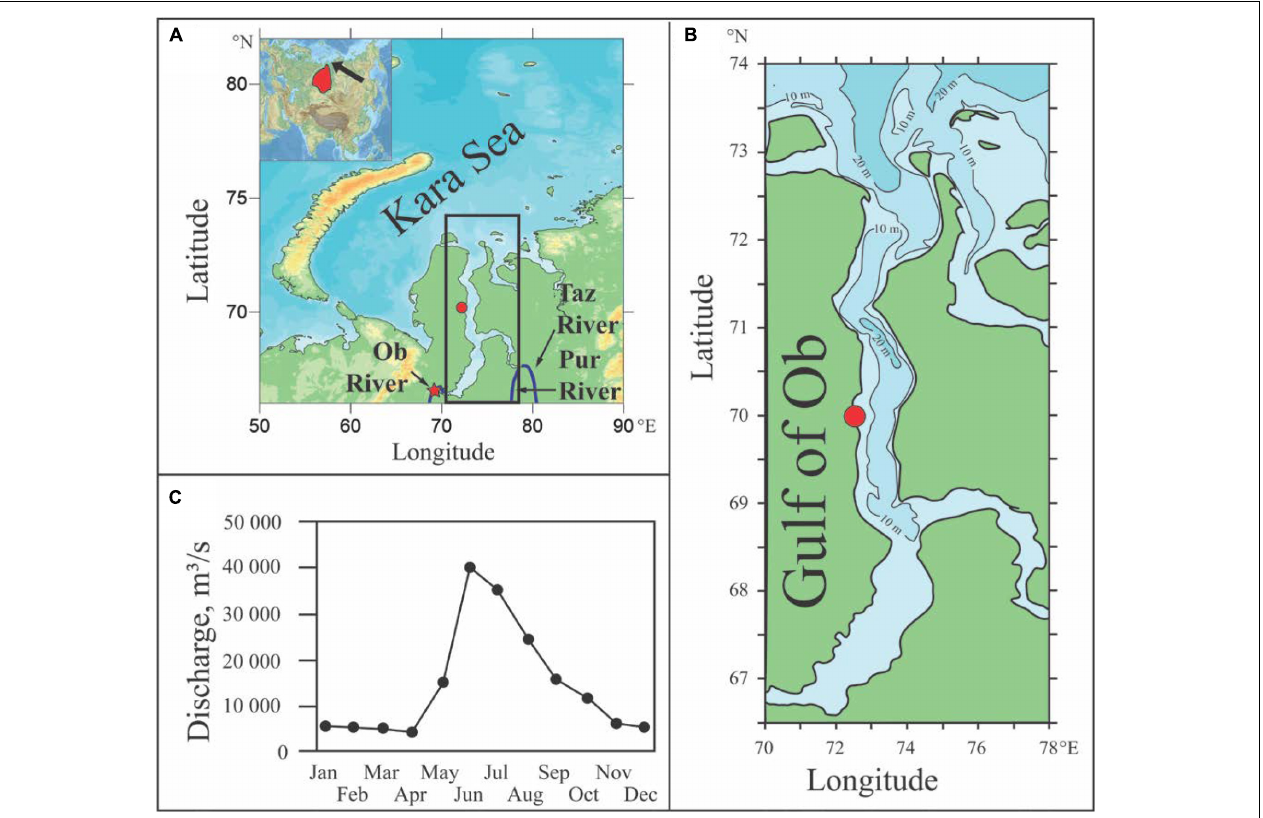
FIGURE 1 | Location of the Gulf of Ob (indicated by the black box) in the Kara Sea (the black arrow at the inset); the main rivers inflowing to the Gulf of Ob; the gauge station in Salekhard (the red star) and the meteorological station in Seyakha (the red circle); the watershed area of the Gulf of Ob shown at the Eurasian map (the red area at the inset) (A) ; bathymetry of the Gulf of Ob (B) ; and mean annual hydrograph of the Ob, Pur, and Taz rivers (C)